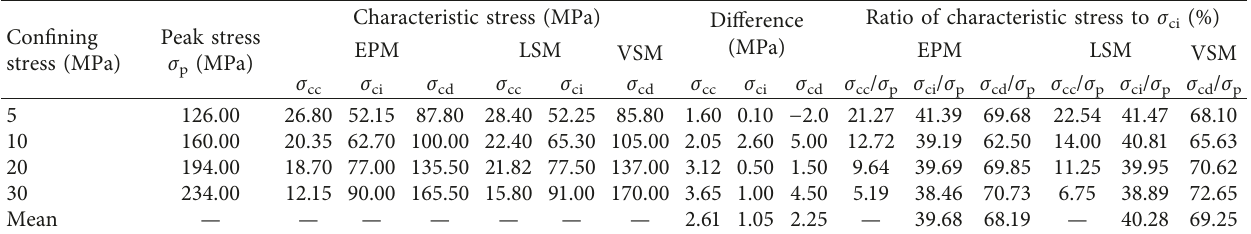
Figure 9: Determination process of characteristic stress by EPM with the confining pressures of 5 MPa (a) and 20 MPa (b). Table 1: Comparison of characteristic stress determined by the three